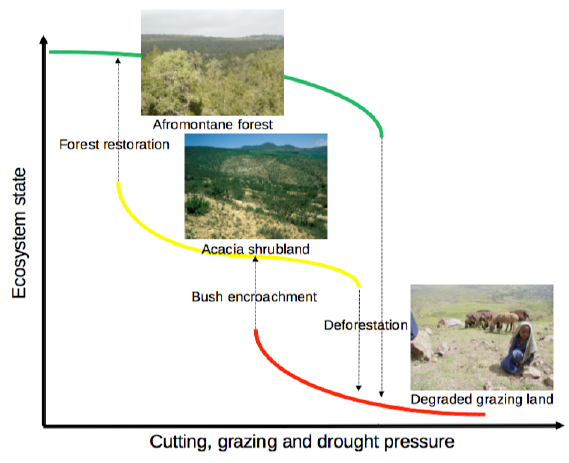
Figure 5. Example based on observations from [62] of an extremely non-linear response of ecosystems to pressures caused by human development, giving existence to alternative stable states and making sustainable development a moving target. The Afromontane Forest of semi- arid northern Ethiopia is well buffered against the effects of human development, but beyond a certain threshold the forest collapses and changes into degraded grazing land. If forest restoration efforts are made, it appears that restoration only becomes possible at much lower pressures than the collapse occurred, and restoration does not directly result in the recuperation of the original vegetation but in a bush state with lower ecosystem services than the original forest. This phenomenon of non-reversibility is called hysteresis, and is a typical indication of alternative stable